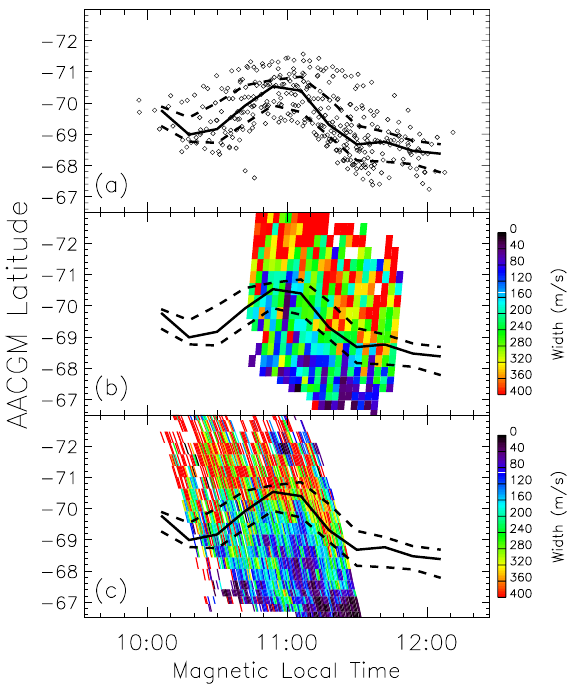
Fig. 4. ( a ) The statistical variation of the spectral width bound- ary position with magnetic local time during the interval 13:50– 15:00UT. Each symbol represents a single observation of the spec- tral width boundary taken from a single beam from a single 3-min scan. ( b ) The spectral width variation seen by Halley beam 8 dur- ing the interval 13:50–15:00 UT. ( c ) The spectral width variation seen by beam 3 during the interval 13:50–15:00 UT. The solid and dashed lines on all the panels represent the median and quartile vari- ations of the scatterplot